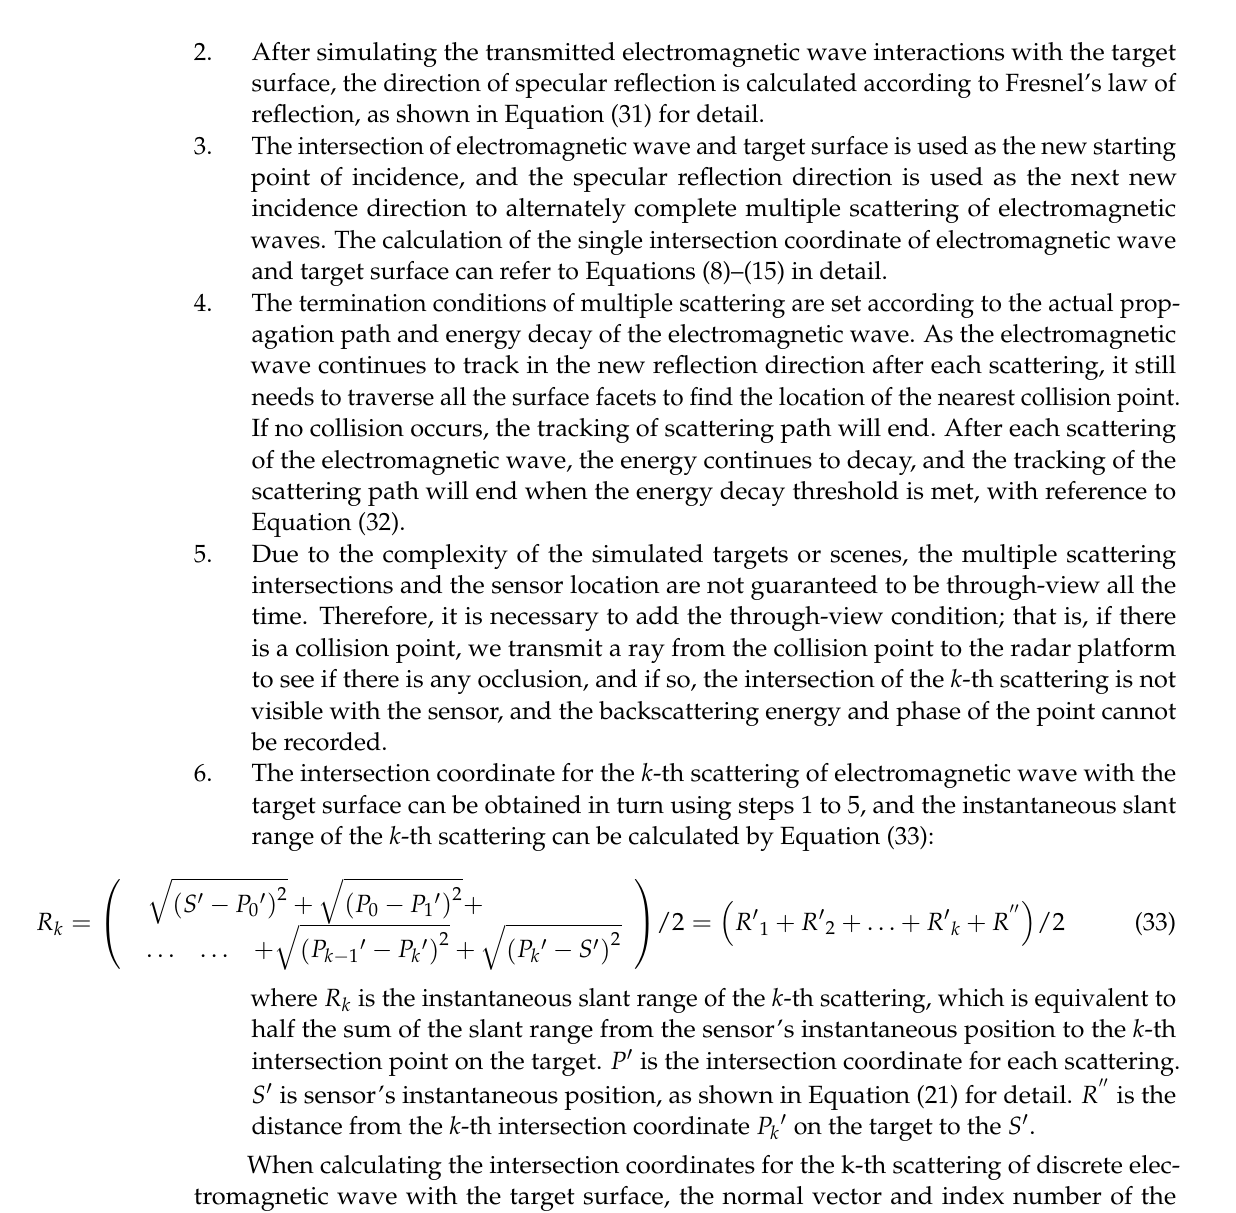
distance from the k -th intersection coordinate P k (cid:48) on the target to the S (cid:48) . When calculating the intersection coordinates for the k-th scattering of discrete elec- tromagnetic wave with the target surface, the normal vector and index number of the corresponding surface facets are also recorded. Refer to the index number to determine the corresponding material diffuse reflection coefficient K d , specular reflection coefficient K f , specular reflection index K s , energy decay coefficient K los , and normal vector surface facet. Backscatter energy includes diffuse energy and energy close to the specular direction. In the process of multiple scattering of each discrete electromagnetic wave and the target surface, electromagnetic waves will intersect with target surface facets with dif-